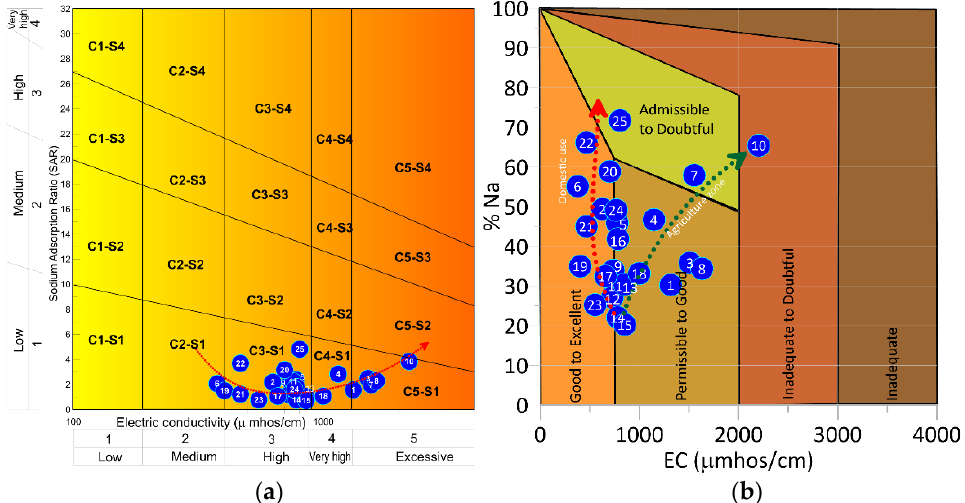
Figure 8. Water classification for the Ahualulco aquifer according to ( a ) Wilcox and ( b ) EC vs. % Na.